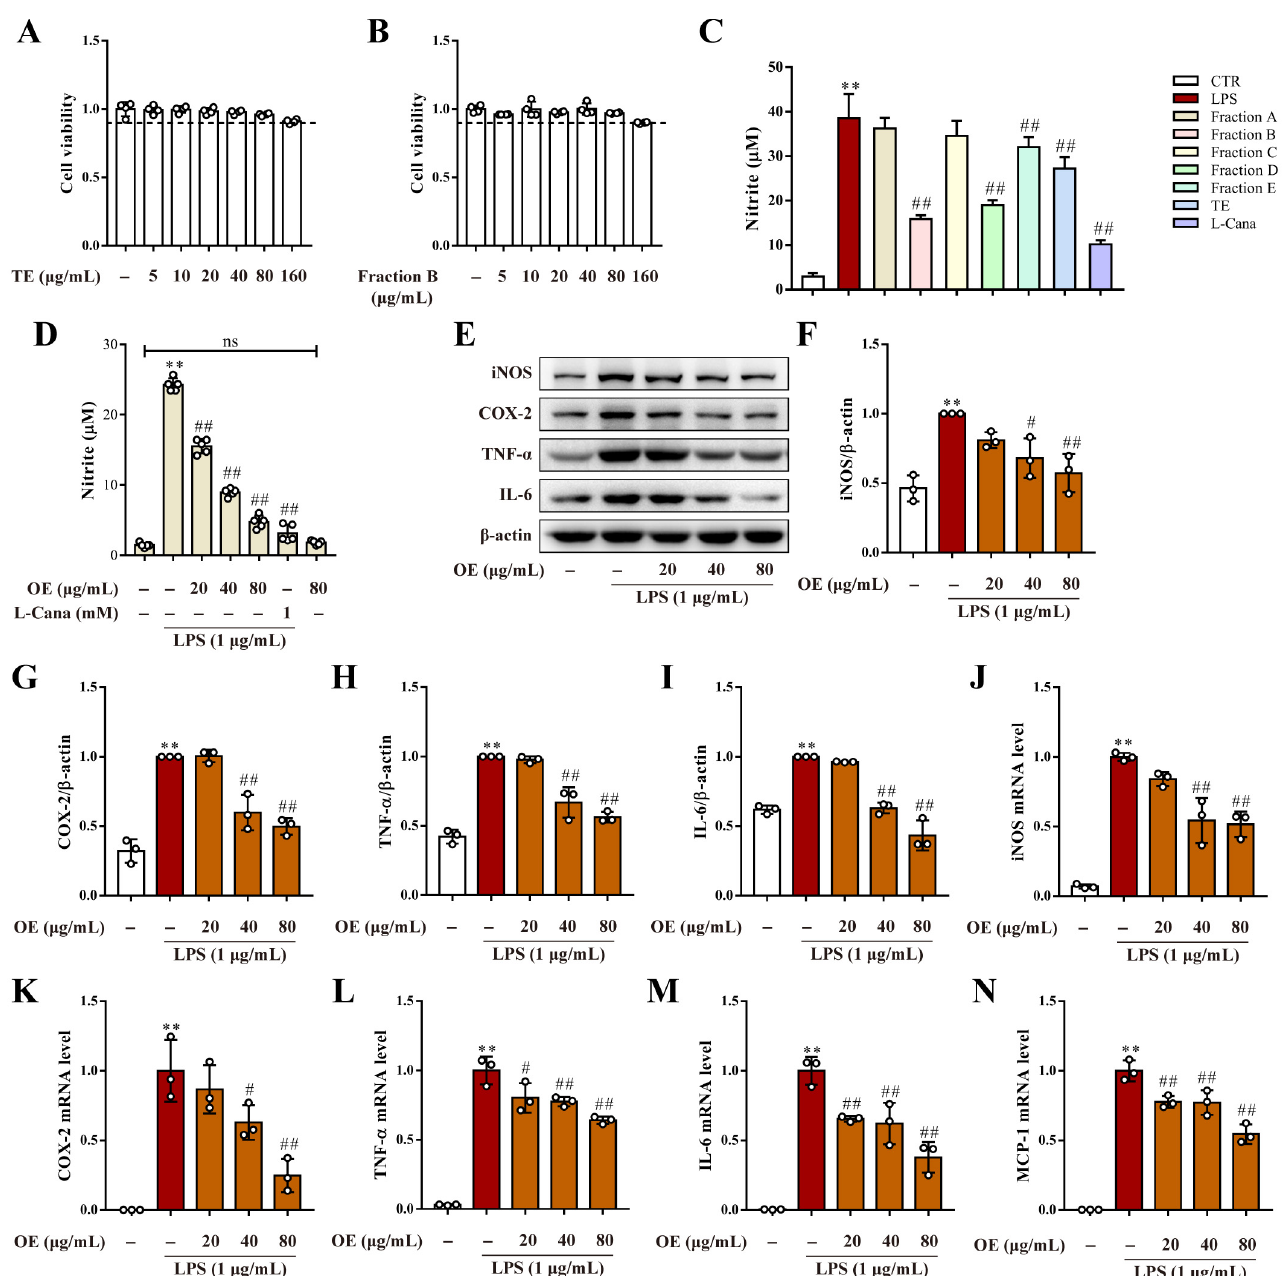
Figure 1. OE alleviated LPS-induced inflammation in macrophages. ( A , B ) Cell viability of TE ( A ) and fraction B ( B ) on RAW264.7 macrophages. ( C , D ) RAW264.7 macrophages were pretreated with the indicated concentration of various substances for 3 h followed by LPS (1 μ g/mL) stimulation for 24 h. The medium was collected to determine the NO release level. ( E – I ) RAW264.7 macrophages were pretreated with OE (20, 40, 80 μ g/mL) for 3 h followed by LPS (1 μ g/mL) stimulation for 24 h. Total protein expression level of iNOS, COX-2, TNF- α , and IL-6 were detected by western blotting assay. ( J – N ) RAW264.7 macrophages were pretreated with OE (20, 40, 80 μ g/mL) for 3 h followed by LPS (1 µ g/mL) stimulation for 6 h. The mRNA level of iNOS ( J ), COX-2 (K), TNF- α ( L ), IL-6 ( M ), and MCP-1 ( N ) were determined by quantitative real time PCR analysis. CTR: control. Data presented as Means ± SD. ** p < 0.01 vs. control group; # p < 0.05, ## p < 0.01 vs. LPS group; ns, no